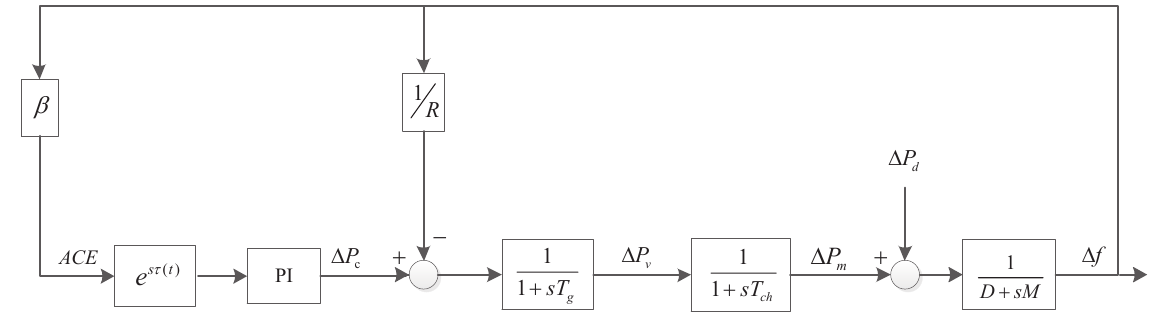
Figure 1. One-area load frequency control (LFC) model diagram.